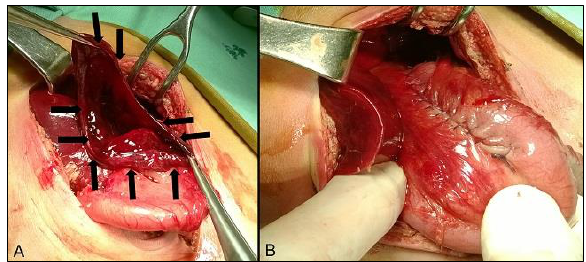
Figure 2: A) intraoperative view of the stomach rupture, B) after